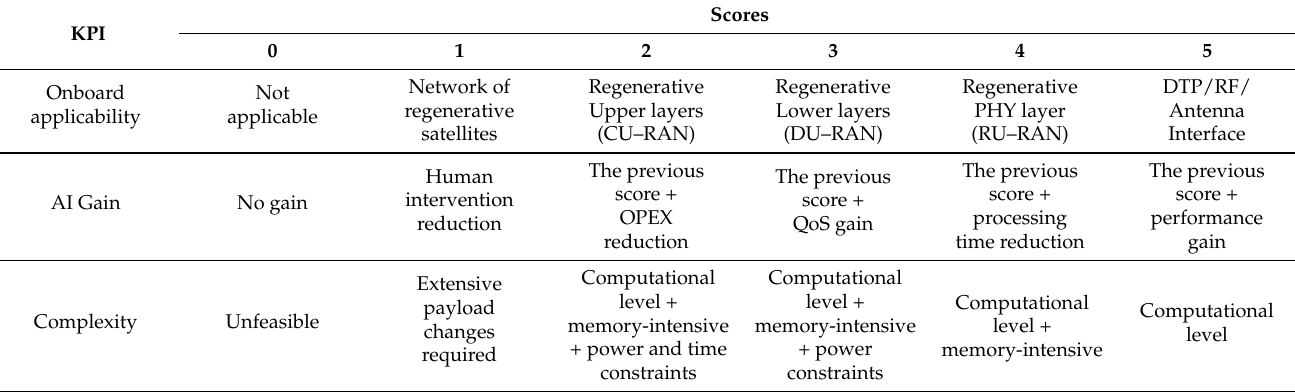
Figure 1. AI chipset implementation in the space segment for onboard processing. The training of the ML algorithm is performed offline in the ground segment with a training database, thus saving the obtained model, and the AI chipset can go on board the satellite using the model for inference. Table 1. KPI analysis for the applicability of onboard AI implementation use